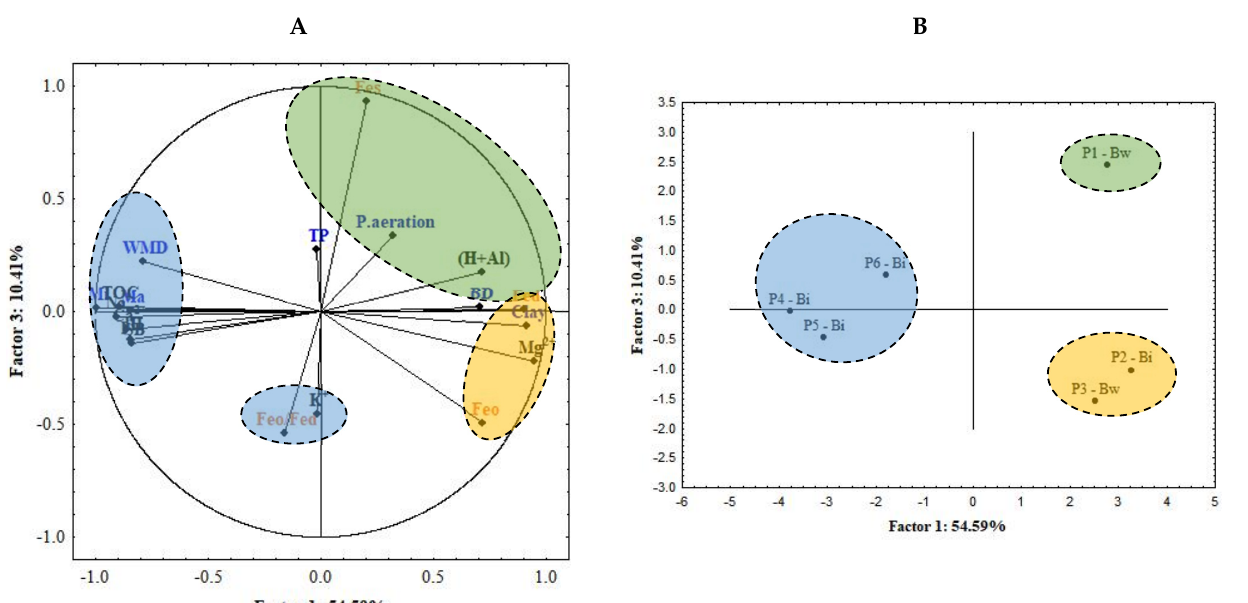
Figure 5. Cloud distribution of ( A ) variables in the correlation circle ( B ) points representing the relates between factors 1–2 and the environments studied. Similar colors represent profiles and their diagnostic horizons and the discrimination of soil attributes.